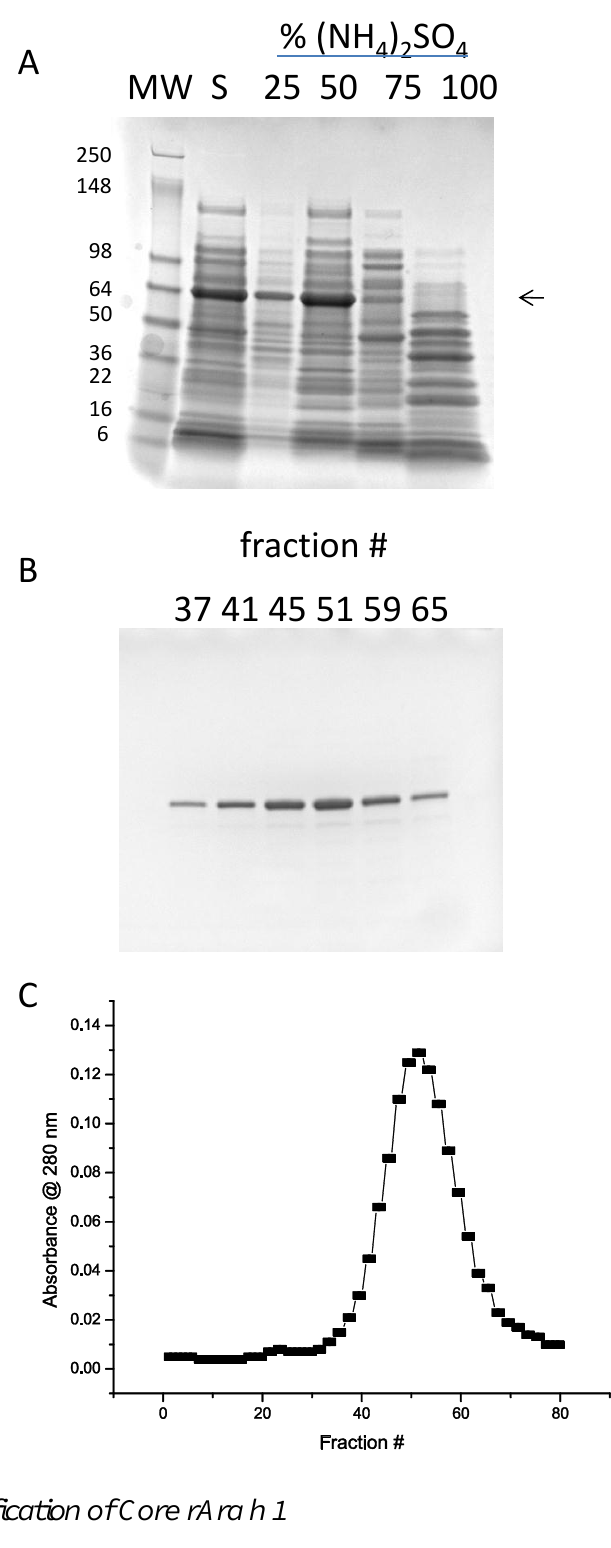
Figure 3. ( A ) SDS-PAGE of ammonium sulfate precipitation tests. “S” indicates the soluble fraction of lysed cells. ( B ) SDS-PAGE of column fractions from High-Q chromatography. ( C ) Elution profile of fractions from High-Q